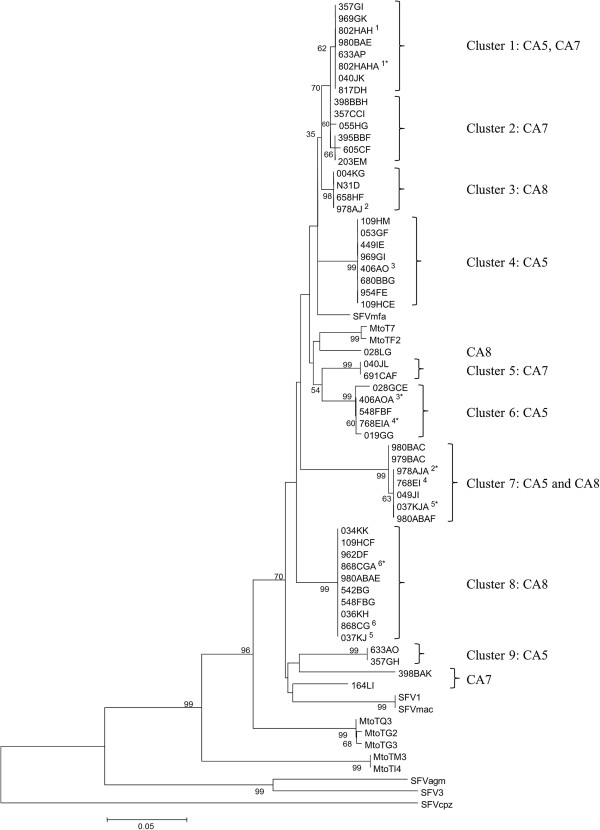
Evolutionary relationships between the 464-bp SFV pol sequences for the cohort of cynomolgus macaques. The evolutionary distances were calculated using the Neighbor-Joining method and are shown as the number of base substitutions per site. The optimal tree is shown. The percentage of replicates in which the sequences clustered together in the bootstrap test (1000 replicates) is shown next to the branches. Branches corresponding to partitions reproduced in less than 50% bootstrap replicates are collapsed. The tree was rooted using a SFVcpz sequence from Genbank, accession number, U04327. SFV sequences from rhesus macaque (SFVmac, accession number X83292; SFV1, X54482), cynomolgus macaque (SFVmfa, AY686197), Tonkean macaques (SFVMtoT7, DQ354076; SFVMtoTM3, DQ354079; SFVMtoTQ3, DQ354073), chimpanzee and African green monkey (SFVagm, X8329; SFV3, M74895) were included for reference. The main nine clusters are indicated and the groups from which the animals are derived are indicated. Dam-infant pairs used to illustrate the reduced emphasis of vertical transmission of SFV in the study (see text) are indicated by a superscript Roman numeral for the dam, and the corresponding numeral with an asterisk for the infant.